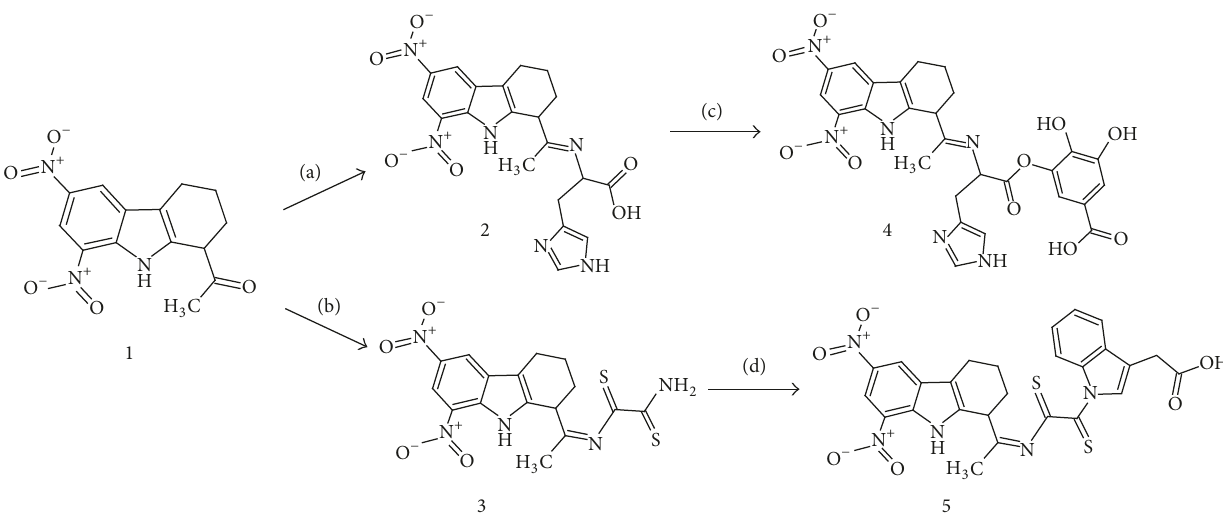
Scheme 1: Synthesis of potential antibiotic compounds 2–5. (a) Histidine, (b) rubeanic acid, (c) indole-3-acetic acid, and (d) gallic